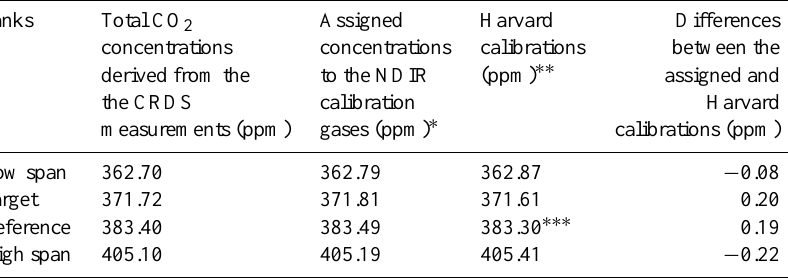
Table 3. Assignment of CO 2 concentrations of the four filling tanks derived from the CRDS analyzer to the calibration gases used by the NDIR analyzer.